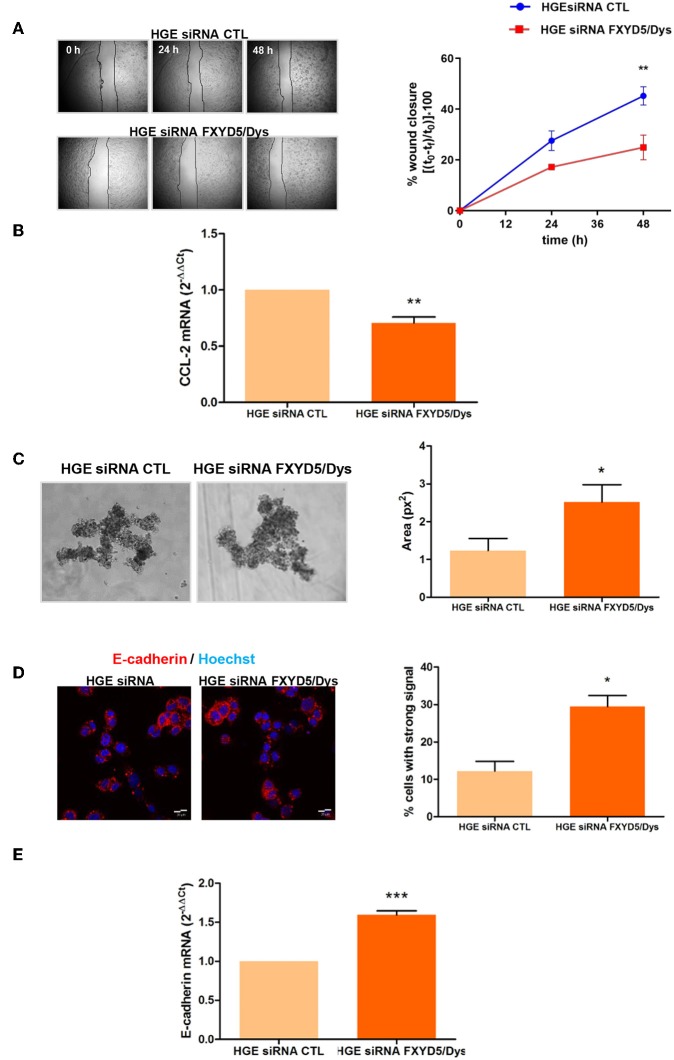
FXYD5/Dys regulation of cell–cell adhesion and cell migration in HGE cells. (A) Left panel: Wound healing assay of HGE siRNA FXYD5/Dys and HGE siRNA CTL cells. Representative images of cells at 0, 24, and 48 h are shown (magnification 40×). Right panel: Free-cell area quantified using ImageJ software. Wound healing closure percentage was plotted at every time point (**P < 0.01, two-way ANOVA, Bonferroni post-test). (B) RT-qPCR analysis of the pro-migratory chemokine CCL-2 expression in HGE siRNA CTL and HGE siRNA FXYD5/Dys cells (**P < 0.01, Wilcoxon signed rank test). (C) Left panel: Hanging drop assay of HGE siRNA FXYD5/Dys and HGE siRNA CTL cells. Representative images of cell aggregates at 72 h are shown (magnification 100×). Right panel: Cell aggregate area was quantified using ImageJ software, and mean cell aggregates areas (expressed as squared pixels) were plotted and compared (*P < 0.05, Mann–Whitney test). (D) Left panel: Fluorescent immunocytochemistry of HGE siRNA FXYD5/Dys and HGE siRNA CTR cell monolayers using anti-E-cadherin monoclonal antibody (610181; 2.5 μg/ml); cell nuclei are visualized using HOECHST 33342. Bar: 20 μm. Right panel: Percentage of cells depicting strong fluorescence intensity quantified using ImageJ software (*P < 0.05, Mann–Whitney test). (E) RT-qPCR analysis of E-cadherin mRNA in HGE siRNA FXYD5/Dys and HGE siRNA CTL cells (***P < 0.0001, Wilcoxon signed rank test).